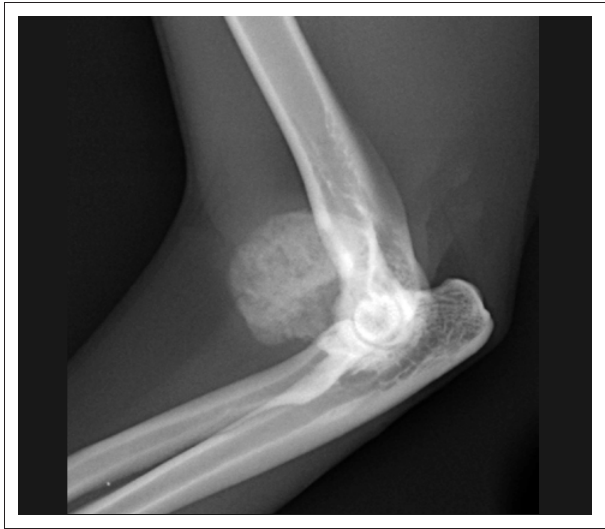
FIGURE 2: Mediolateral view of the left elbow of a cat positive for feline leukaemia virus. The mineralised, well-circumscribed mass is seen dorsolaterally to the left elbow joint.